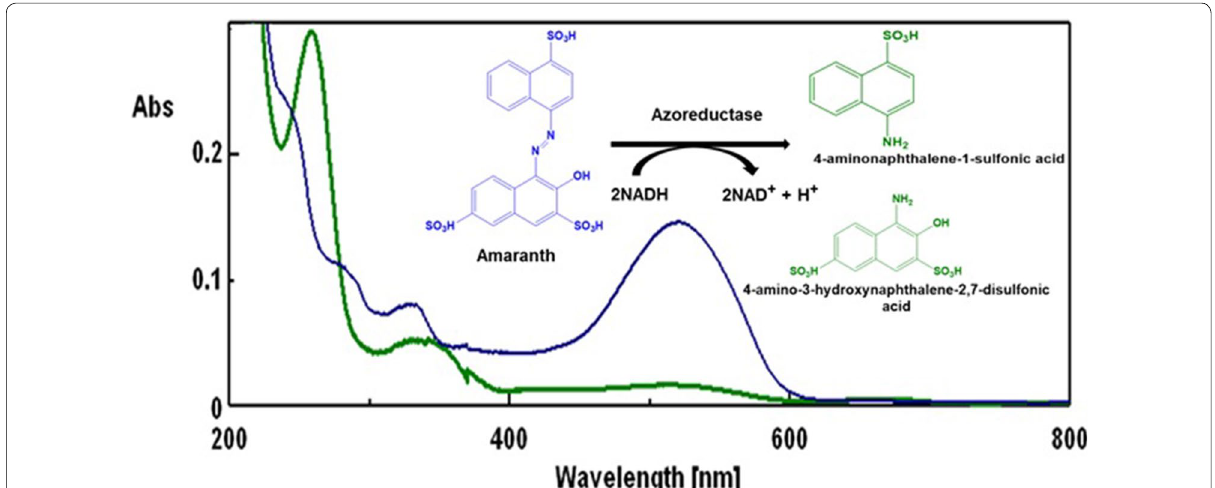
Fig. 1 Azoreduction mechanism of amaranth dye by azoreductase enzyme: The UV–Visible spectrum demonstrating the complete reduction of amaranth dye in 24 h of incubation with purified azoreductase. Blue spectrum was recorded at zero time and green was recorded at 24